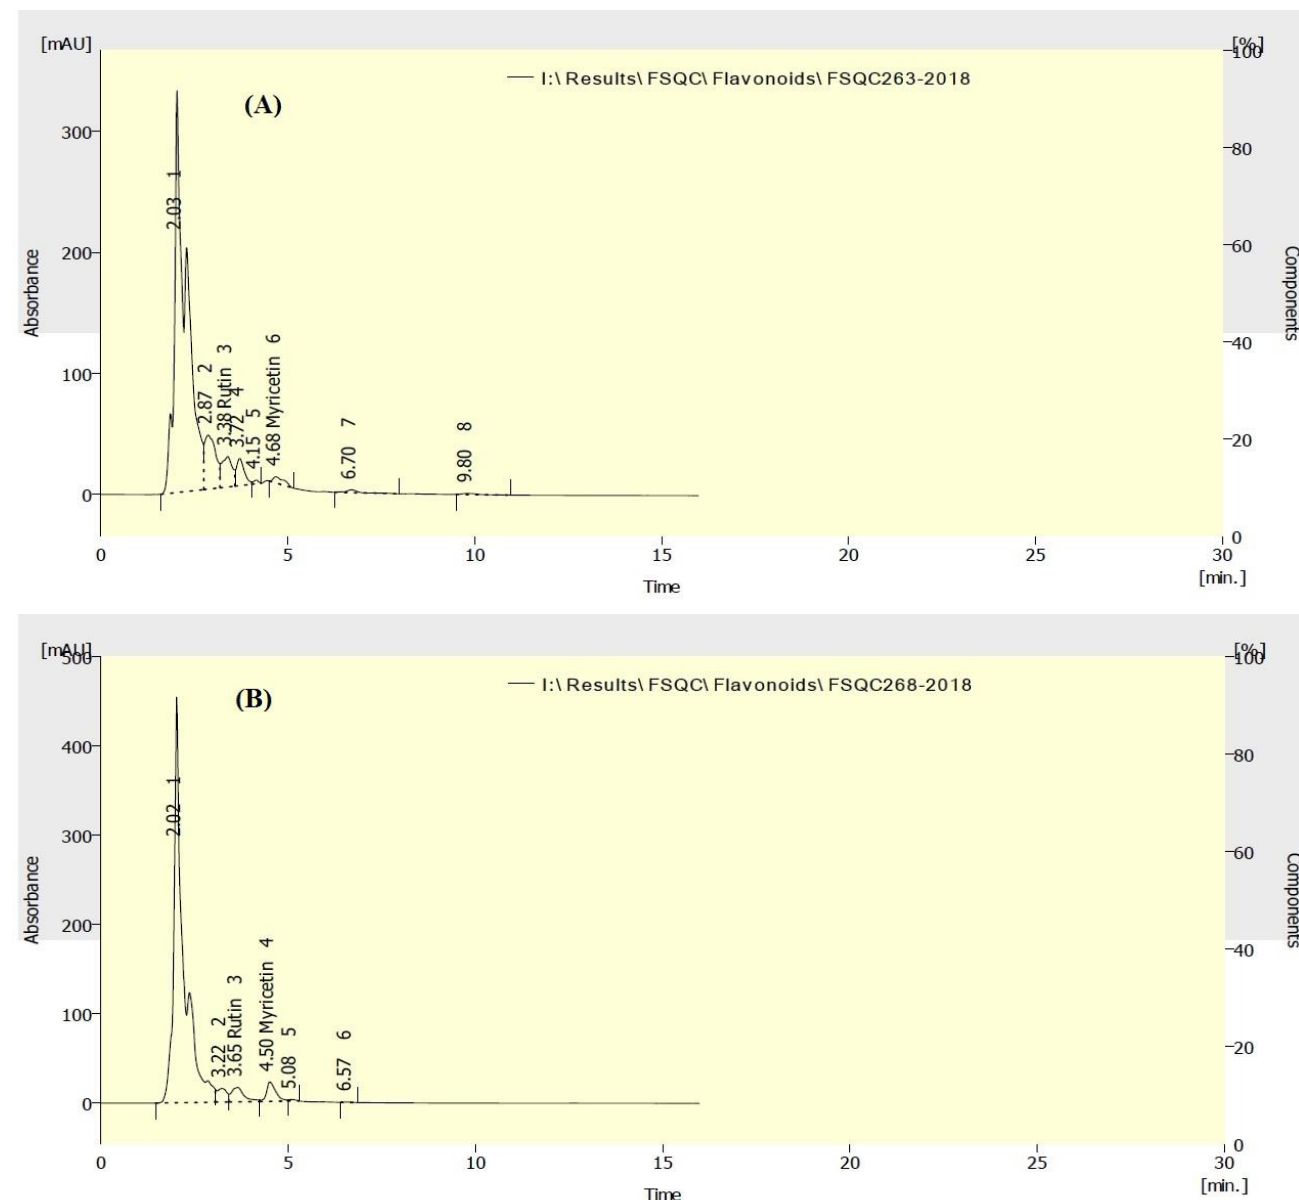
Figure 6. HPLC chromatograms for quantification of rutin and myricetin in ( A ) Plectranthus neochilus and ( B ) Parthenocissus quinquefolia extracts.